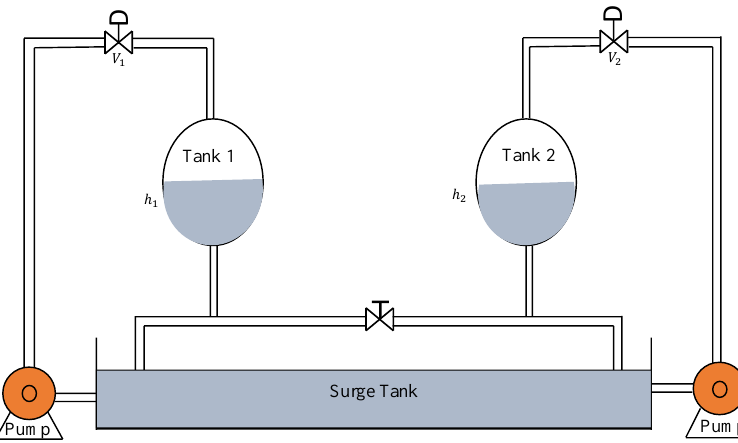
Figure 13. Coupled Spherical Tank